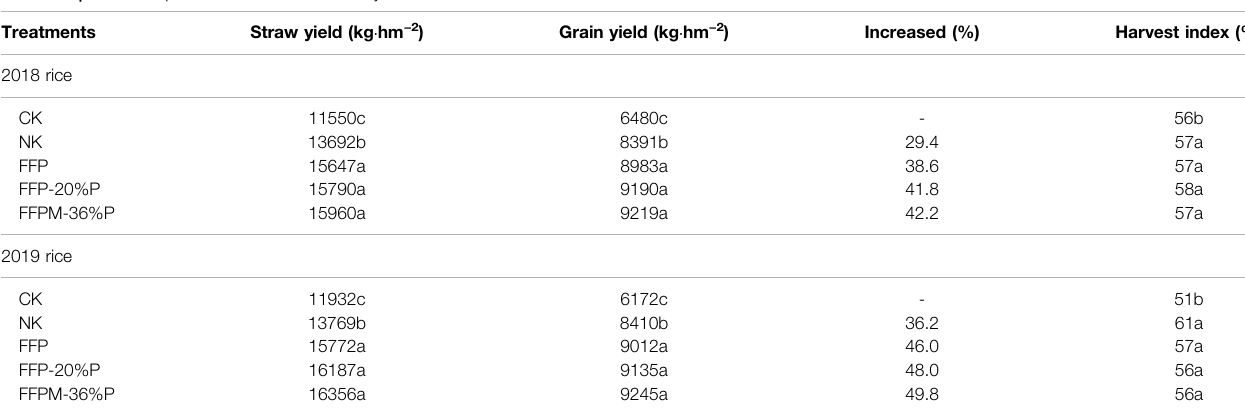
TABLE 5 | Effect of optimized fertilization on rice yield.